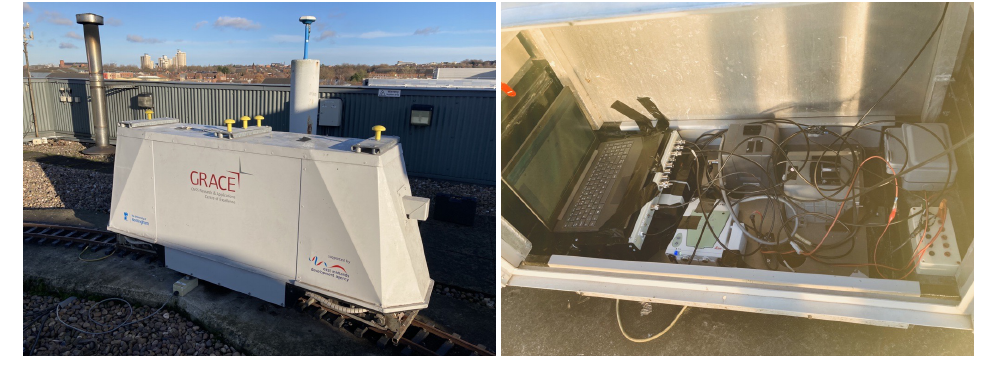
Figure 1. NGI test train.